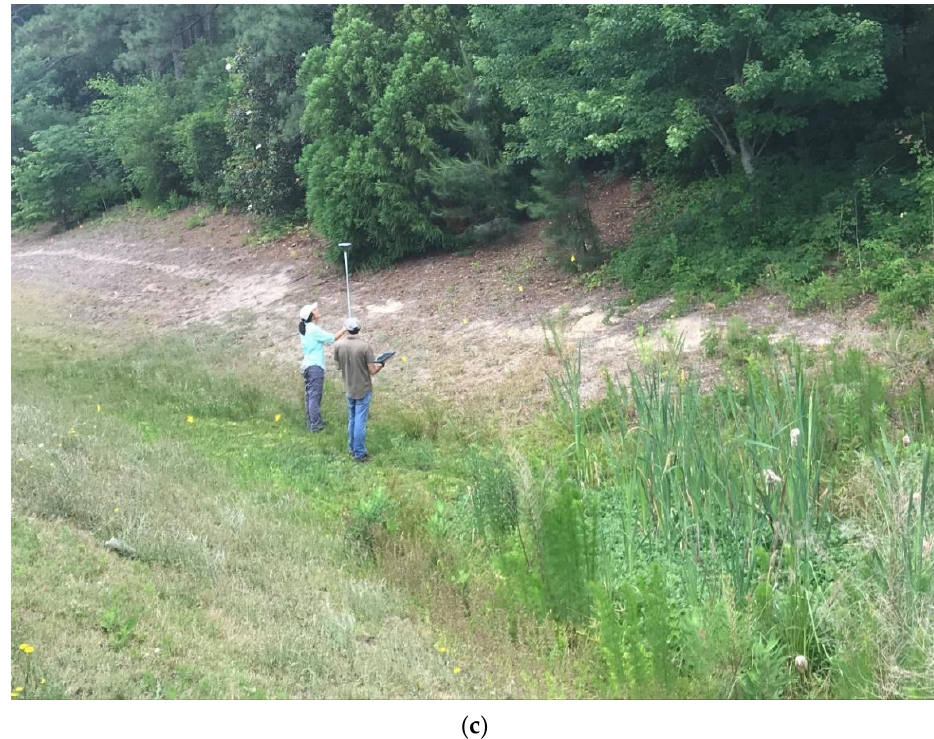
Figure 2. The hybrid dry basin/wetland is covered with 40% wetland plants, such as cattails ( Typha sp.), near the inlet ( a ), while the rest of the surface area is mostly grass ( b ). The boundary between wetland plants and upland plants is shown in ( c ).